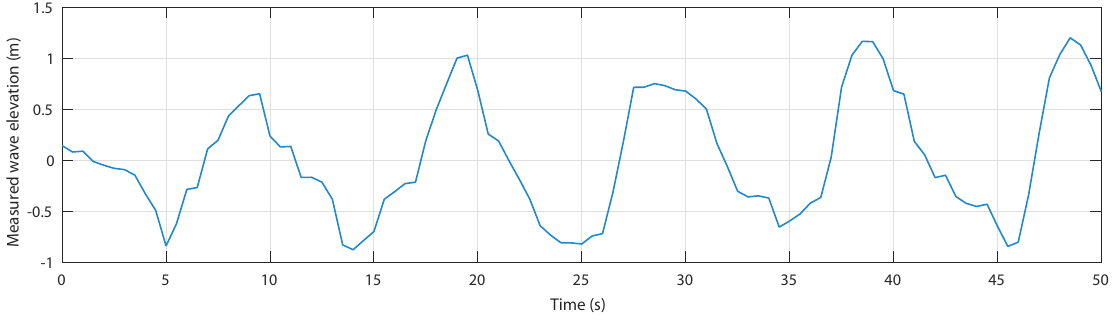
Figure 25. Measured wave input for the implemented OWC model.